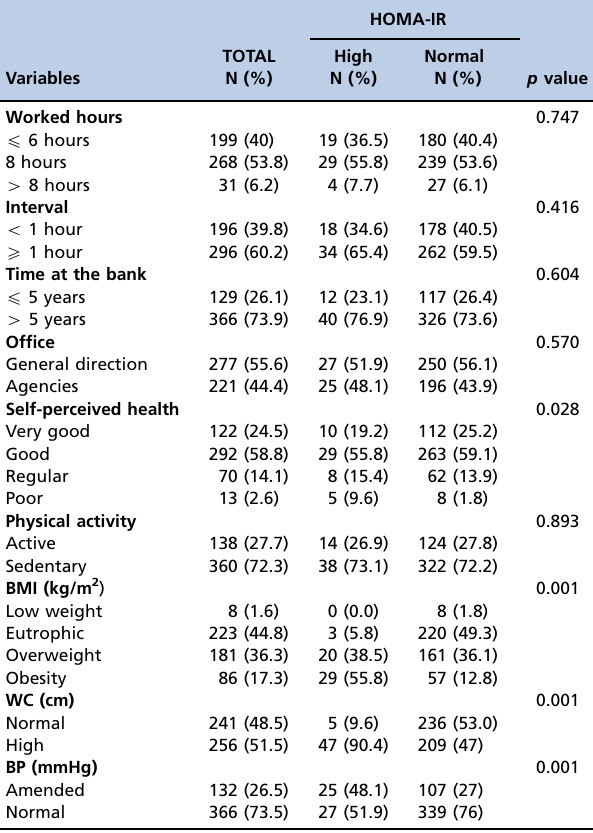
N = 498, different values from the mean data loss Chi-square test HOMA-IR: Homeostasis model assessment; BMI: body mass index; WC: waist circumference; and BP: blood